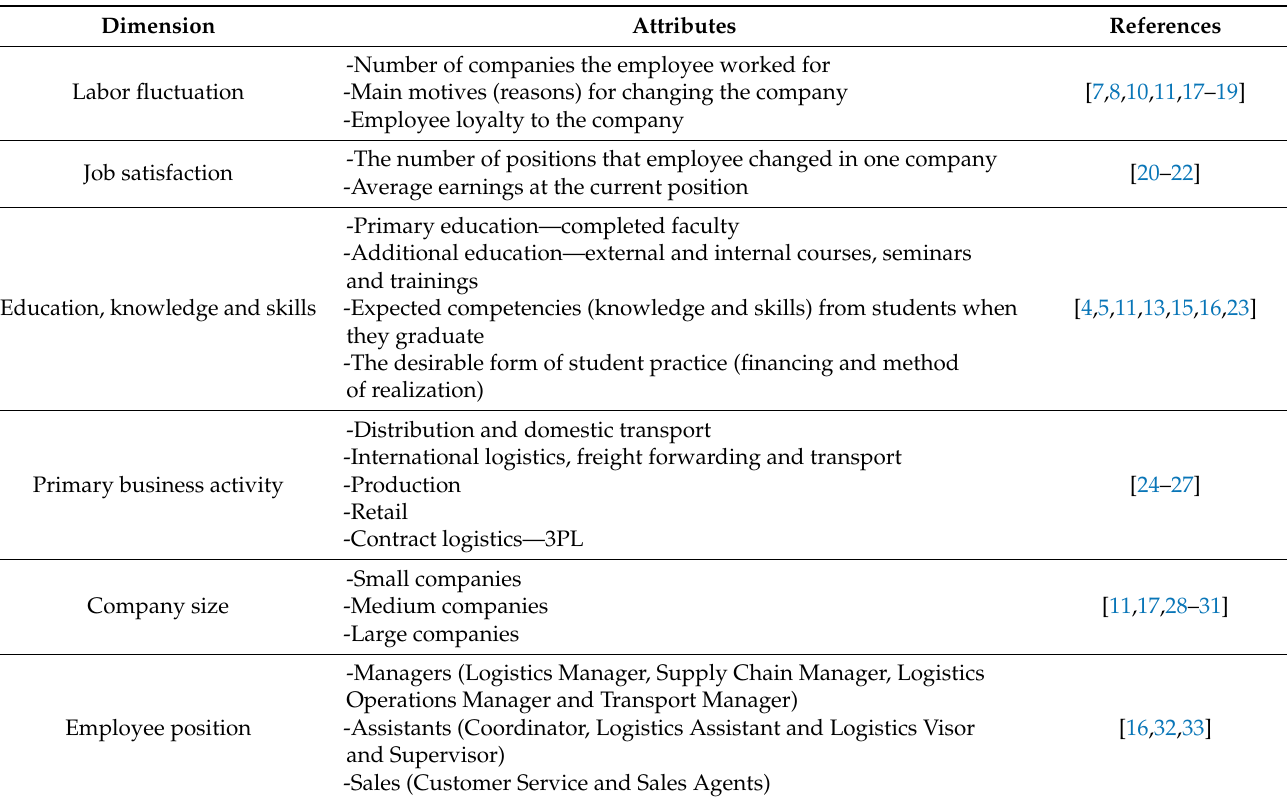
Table 1. Variable